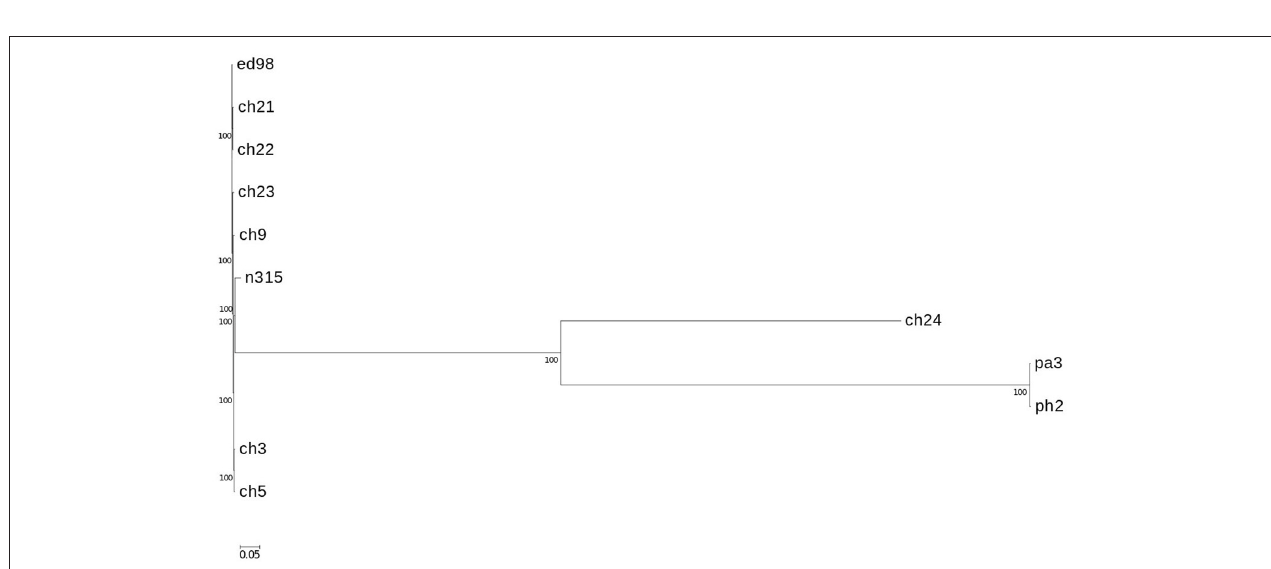
FIGURE 3 | Phylogenetic relationship of strains mapped against reference type strain ED98. Phylogenetic maximum likelihood tree constructed on the basis of SNPs was obtained by CSI phylogeny 1.4. A confidence score ranging from 0 to 1 ( × 100 during visualization in MEGA6 software) was calculated for robustness evaluation of the nodes. The scale bar indicates the evolutionary distance between the sequences determined by 0.05 substitutions per nucleotide at the variable positions.